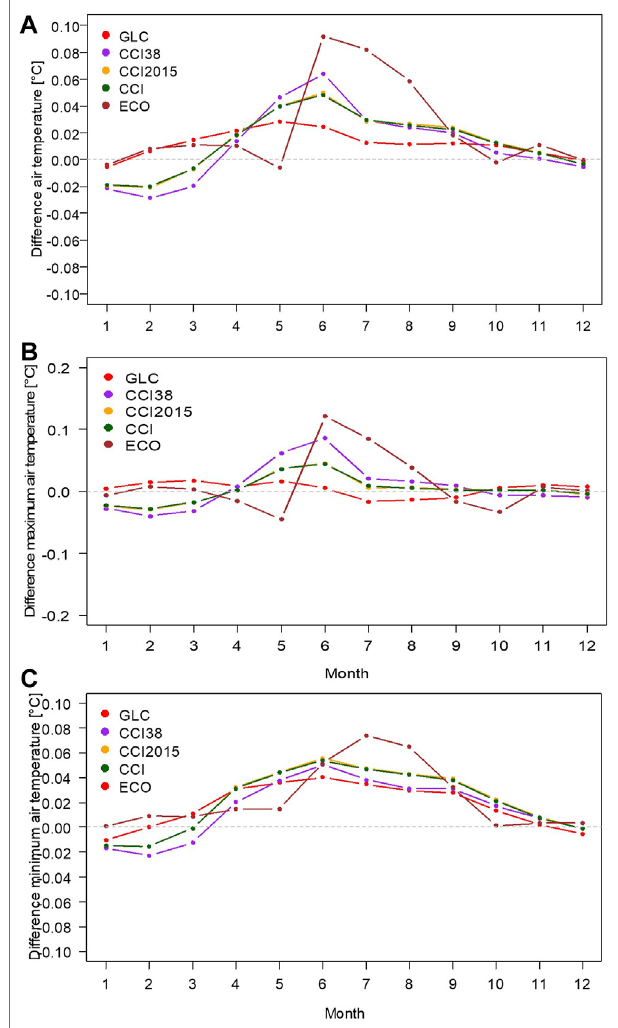
FIGURE 4 | Annual cycle climatology (2002 – 2011) of the differences in 2-m temperature (A) , maximum temperature (B) and minimum temperature (C) in the simulation experiments with land cover map GLC (red), CCI38 (purple), CCI 2015 (yellow), CCI (green), and ECO (brown) compared with the control simulation based on GC. Please see Table 1 for